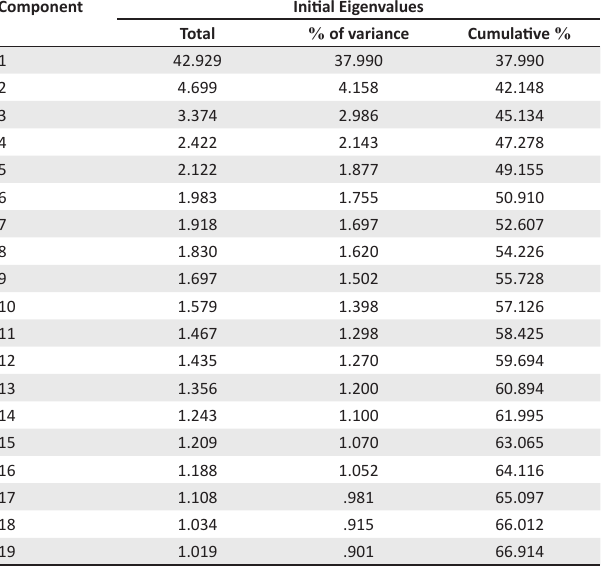
TABLE 2: Factor extraction using principal component analysis. Component